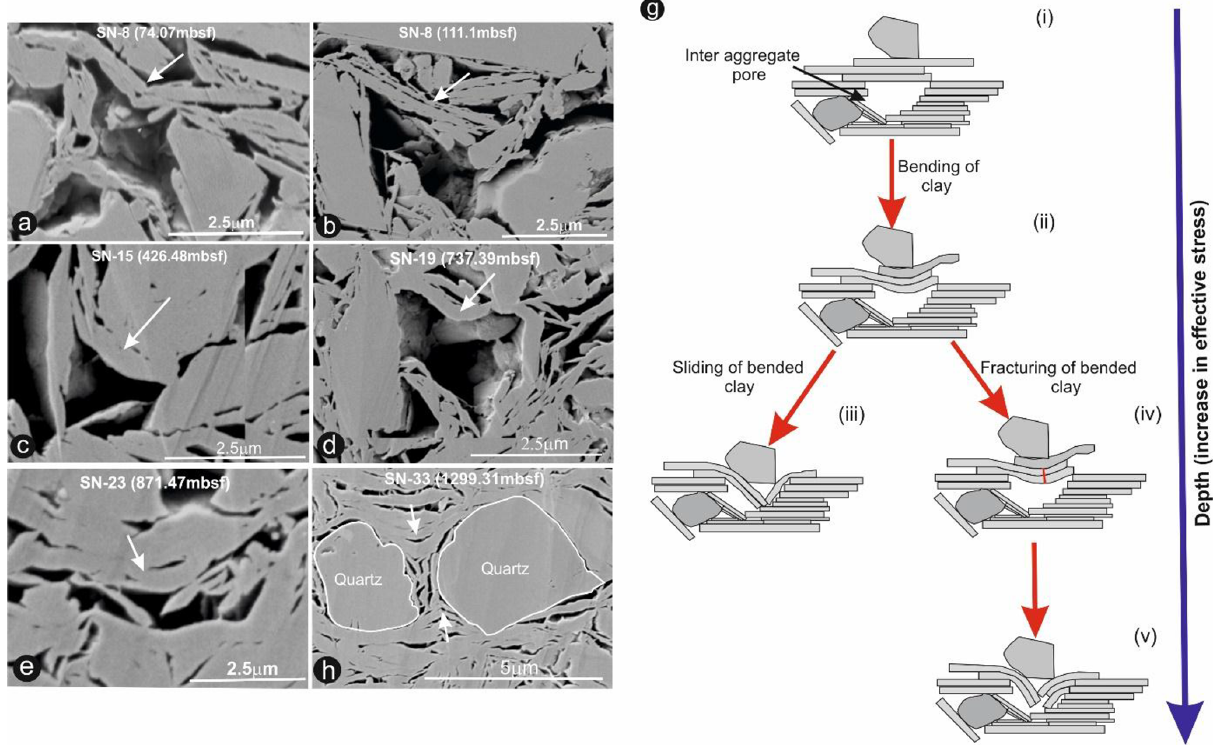
Figure 13. (a–f) Examples of bent clay particles on top of silt-adjacent larger pores; sample ID and depth are labeled in photos. (g) Microme- chanical model for collapse of large silt-adjacent